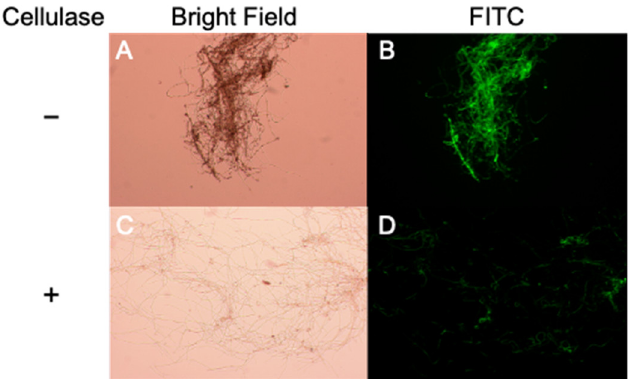
Figure 4. TAD1 accumulated to a high level within the EPS layer. Microscopic observation of M. nivale mycelia after incubating spores at 15 °C for 7 days with FITC-labelled rmTAD1 (10 µg/mL) through bright field and FITC filter sets. The first row ( A , B ) represents the images without cellulase. The second row ( C , D ) represents the images with cellulase.